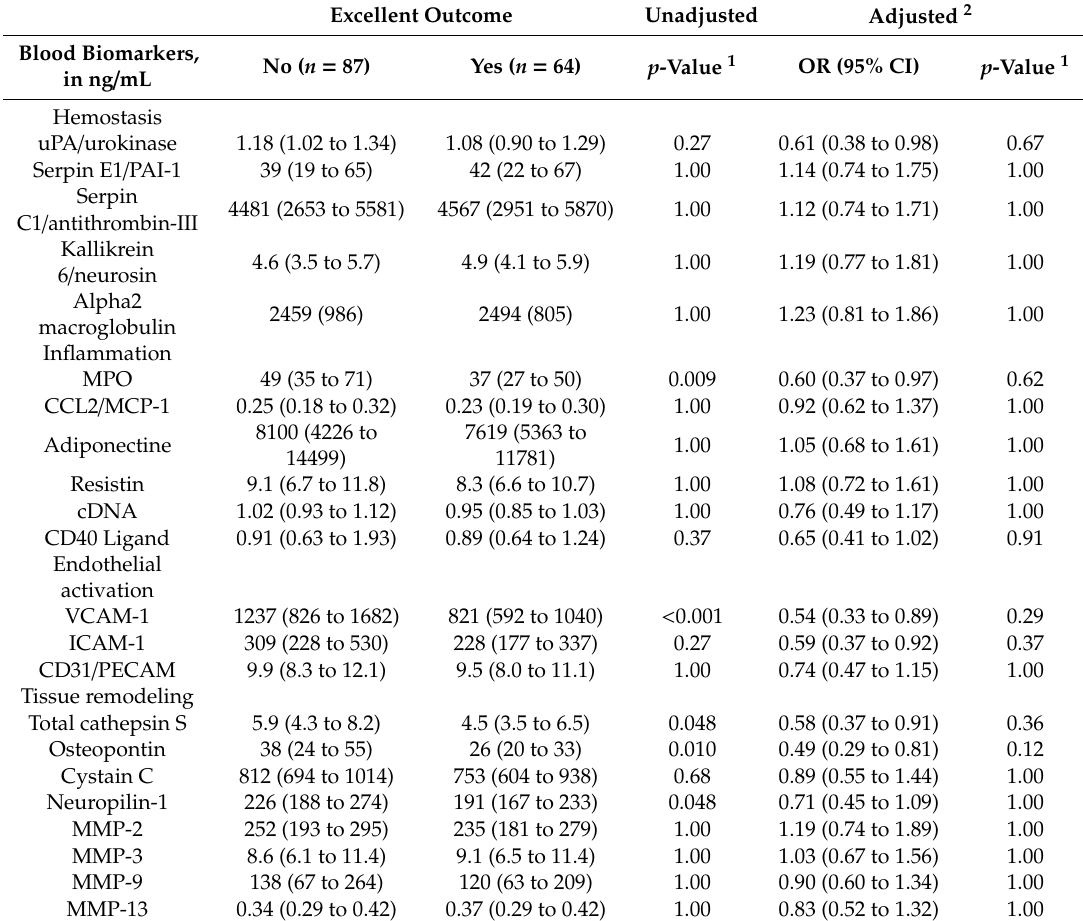
Table 3. Associations of biological markers with a excellent